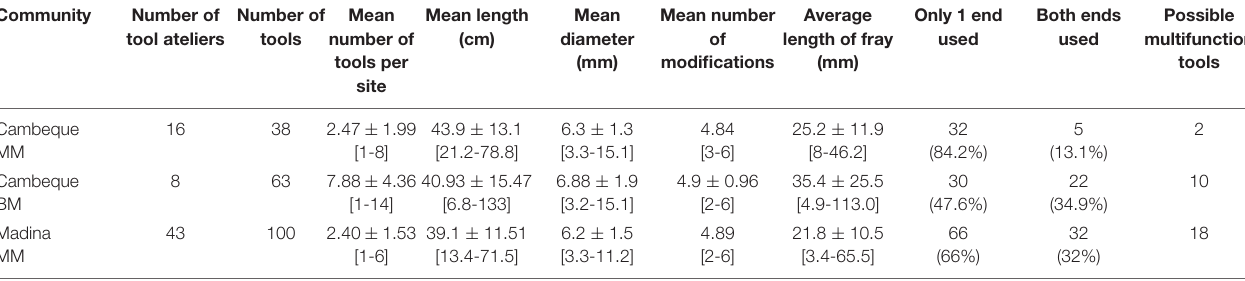
TABLE 2 | Summary of tools and tool characteristics as a function of chimpanzee community. Community Number of